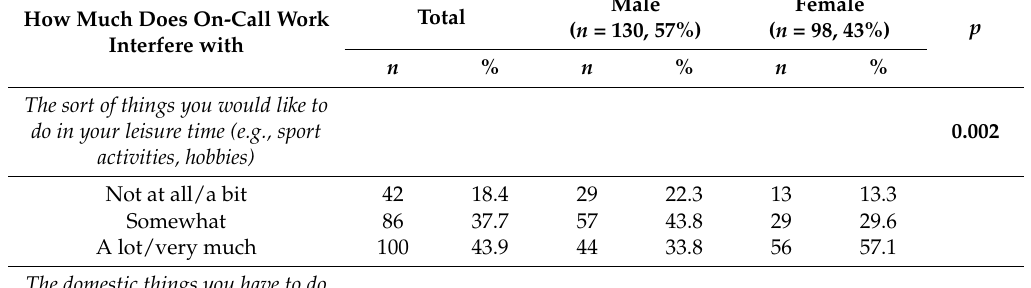
Table 2. Perceived interference of on-call work with leisure, domestic, and non-domestic duties. How Much Does On-Call